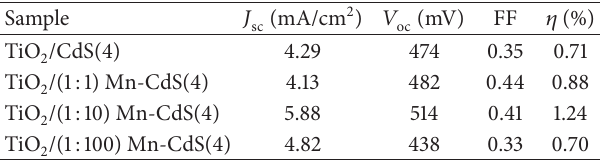
Table 1: Different photovoltaic parameters for different samples.